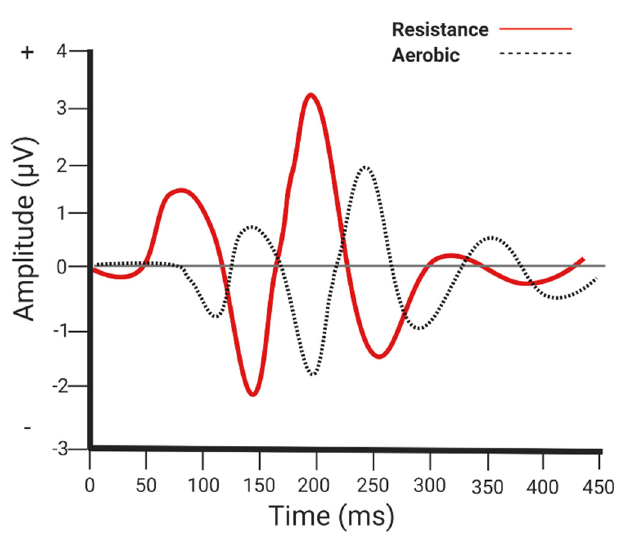
Figure 3. Neuroelectrical parameters. Aerobic and resistance exercise both improve event-related potential parameters of memory function; however, resistance exercise produces a shorter latency and greater amplitude of various event related potentials compared to aerobic exercise.